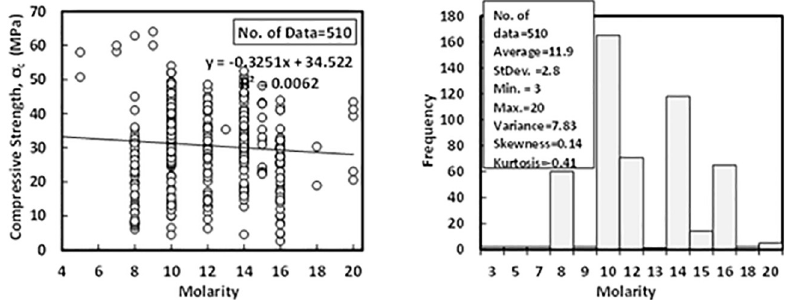
Fig 10. Variation between compressive strength and molarity with a histogram of fly ash-based geopolymer concrete mixtures.